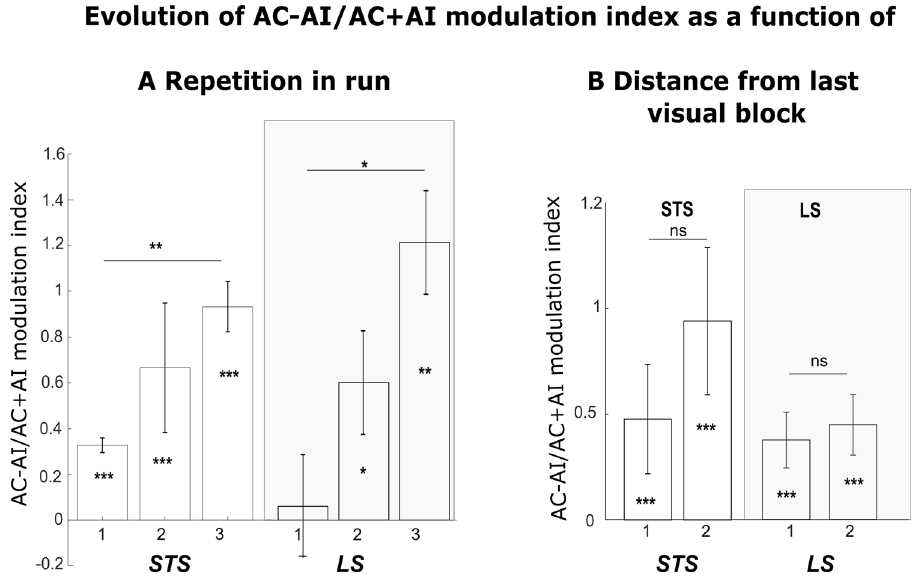
Fig. 5 | Distribution of AC-AI/AC+AI modulation index as a function of repeti- tioninrunanddistancefromlastvisualblock. Distributionofmodulationindex ofpercentagesignalchange(%SC)fortheACconditionrelativeto fi xationbaseline compared to the AI condition relative to fi xation baseline (AC − AI/AC+AI), as a function of repetitionorder inthe run ( A ) or asa functionof the distancefrom the lastvisualblock( B ),foreachoftheSTSandLS,andeachofthefaceandsocialruns, computedonindividualROIsacrossallruns.In( A ),1: fi rstoccurrenceofACorAI,2: secondoccurrence,3:thirdoccurrence.In( B ),1:ACorAIjustfollowingablockwith visual stimuli presentations, 2: AC or AI presented two blocks away from a